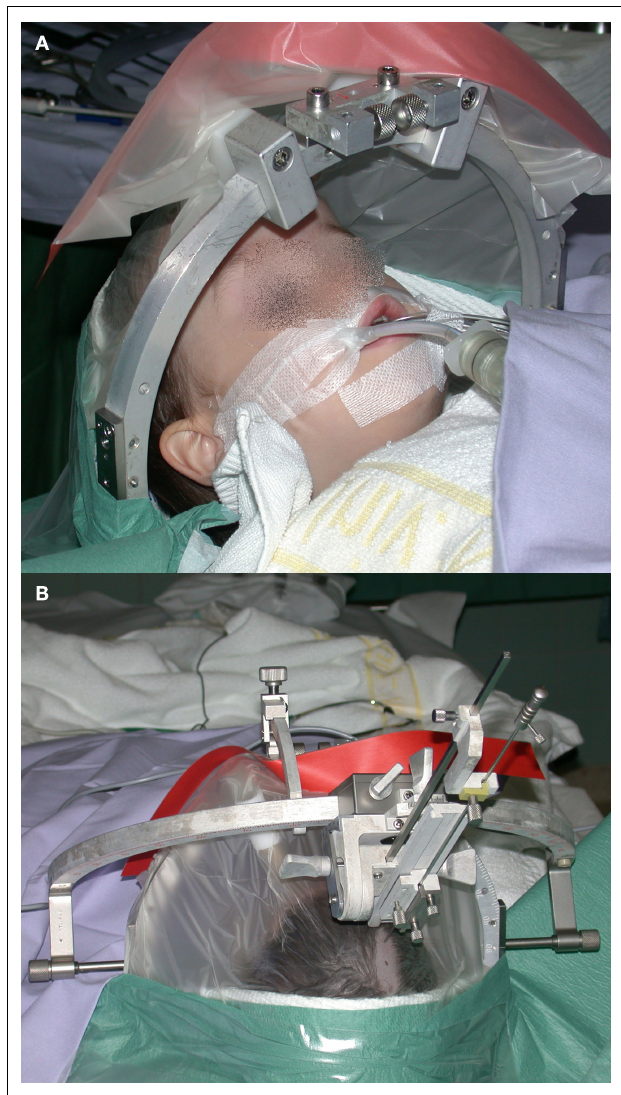
FIGURE 1 | (A) Child fixed in a stereotactic ring under general anesthesia in preparation for a stereotactic procedure. (B) Stereotactic aiming bow with a probe pointing to the shaved frontal entry